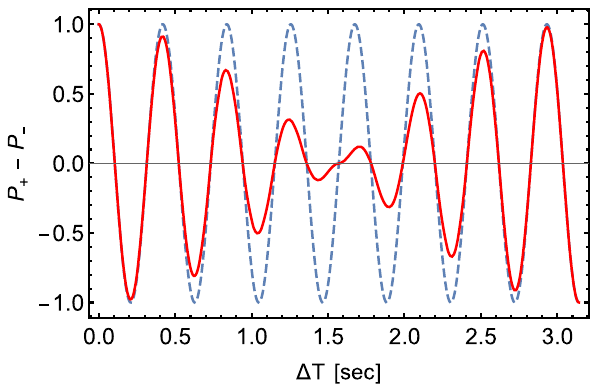
Fig. 4 Quantum interference in GR. The blue dashed line corresponds to the coherent oscillation due to the COW effect, whereas the red solid line represents the interference pattern in the presence of time dilation. One can explicitly notice that, because of time dilation, there is a loss of coherence.Forthesakeofargument,wehaveset (cid:15) (cid:19) (cid:14) h (cid:14) E /( 2 ¯ hc 2 ) = 1 Hz, m (cid:15) (cid:19) (cid:14) h / ¯ h = 15 Hz, φ = β = 0